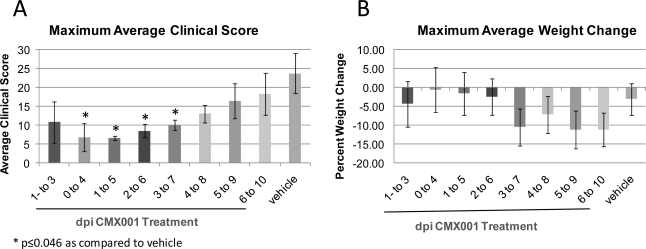
Disease severity measurements for evaluation of survival when dosage with CMX001 is delayed up to six days post infection. Animals were dosed at concentrations and schedules as outlined in Table 3. (A) Average of maximum clinical scores for each animal per group over the course of the experiment. (B) Average of maximum percent weight loss from weight at day 0 for each animal per group over the course of the experiment.